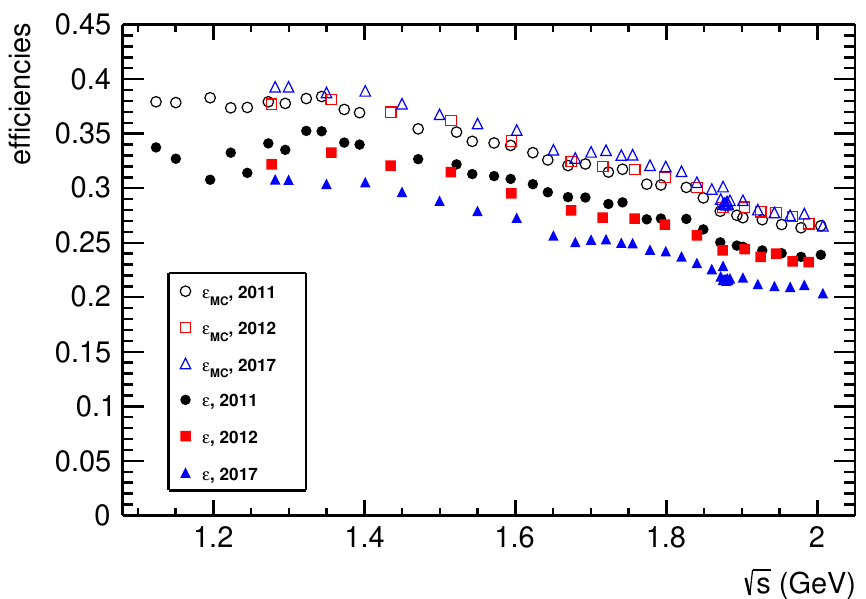
Figure 6 . The e + e (cid:0) ! (cid:17)(cid:25) + (cid:25) (cid:0) detection e(cid:14)ciencies for 2011, 2012 and 2017 data samples. The e + e (cid:0) ! (cid:17)(cid:25) + (cid:25) (cid:0) Monte Carlo detection e(cid:14)ciencies are indicated with empty markers while those with corrections with (cid:12)lled